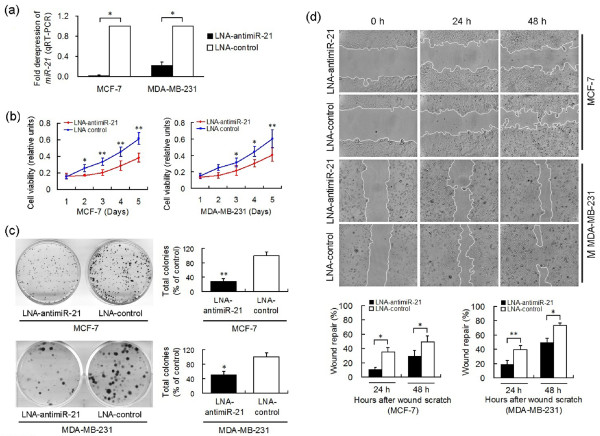
LNA-antimiR-21 suppressed BC cell growth, proliferation and migration in vitro. (a) miR-21 expression levels (normalized to U6 RNA) were significantly depressed by 98% (P < 0.01) in MCF-7/LNA-antimiR-21 and 77% (P < 0.01) in MDA/LNA-antimiR-21 cells, relative to the LNA-control. The graph shows RQ calculated by normalizing the miR-21 expression values in LNA-antimiR-21 treated cells on those in the LNA-control treated cells. (b) MTT assay showed that MCF-7/antimiR-21 and MDA-MB-231/antimiR-21 cells grew slower than cells transfected with the LNA-control. (c) Representative wells showing total numbers of colonies formed by LNA-antimiR-treated cells standardized against control cells (set to 100%). (d) Representative image of in vitro wound healing assay of MCF-7 and MDA-MB-231 at 0, 24 and 48 h after wound scratch. Data are mean + SD, n = 3. * P < 0.05, ** P < 0.01.